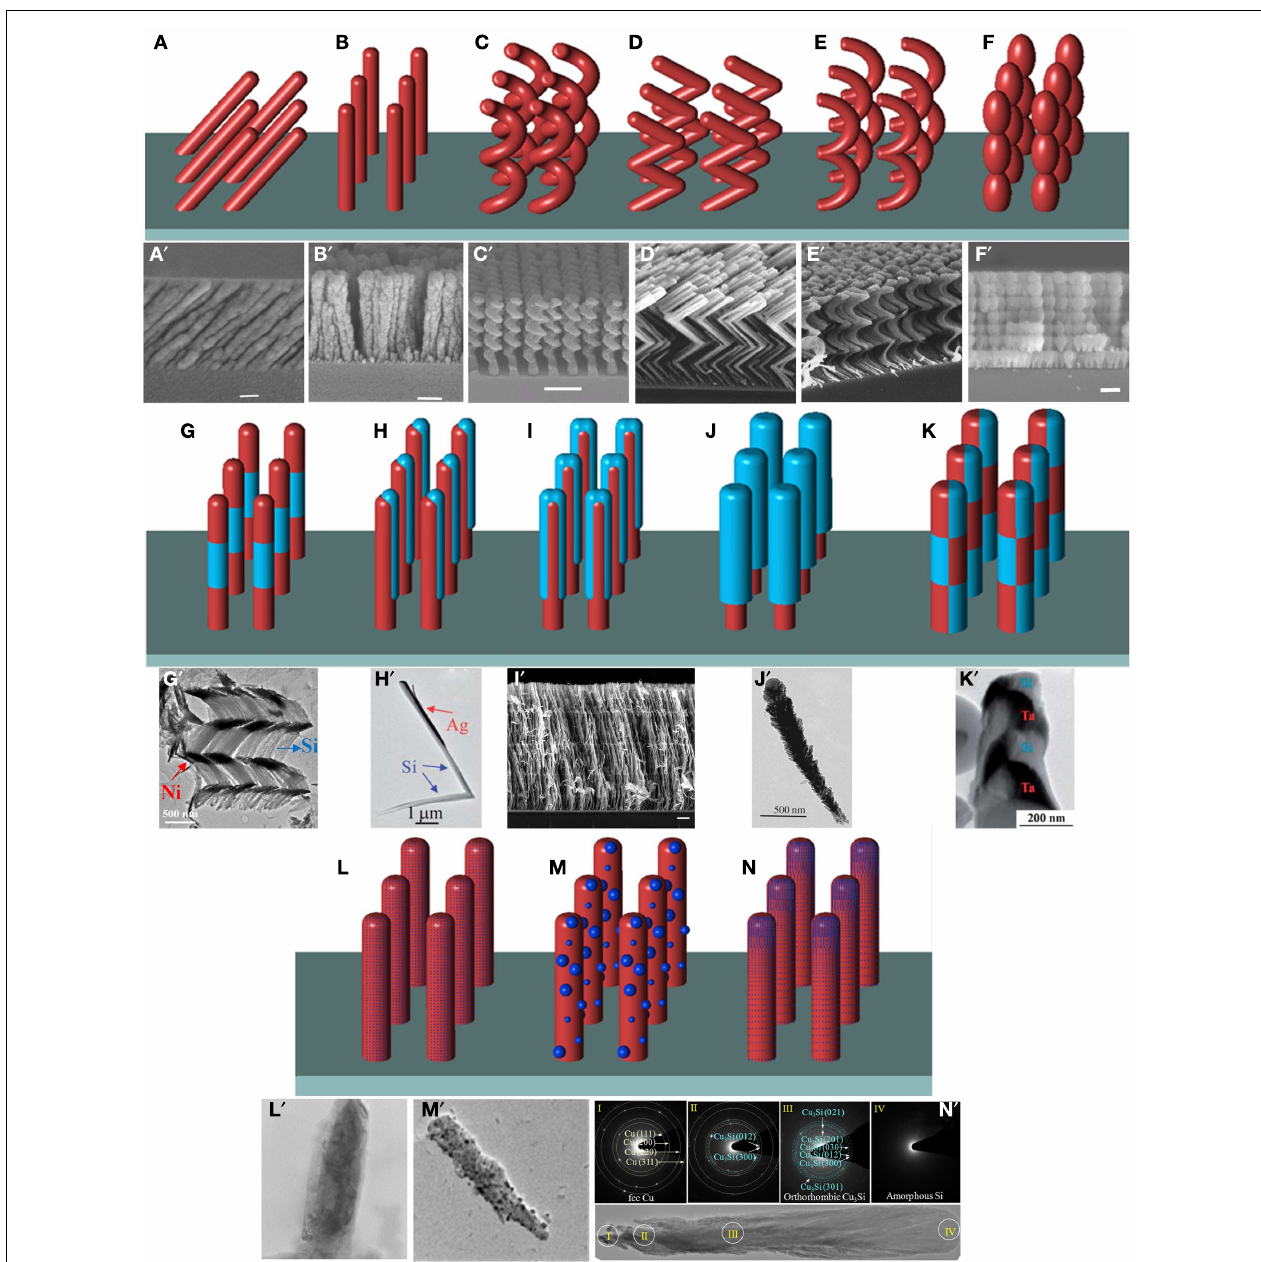
et al., 2007b). Copyright 2007 American Chemical Society]; (I) sandwiched nanorods and (i’)V/Mg sandwiched nanoblades for hydrogen